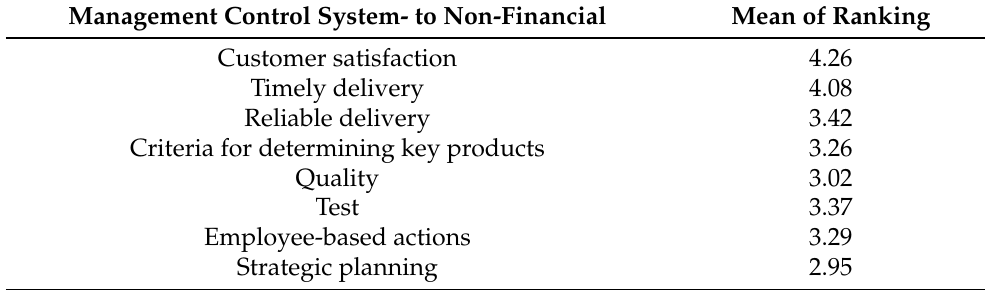
Table 16. Mean of ranking in tested dimensions in management control system- to non-financial variable based on Kruskal–Wallis test.